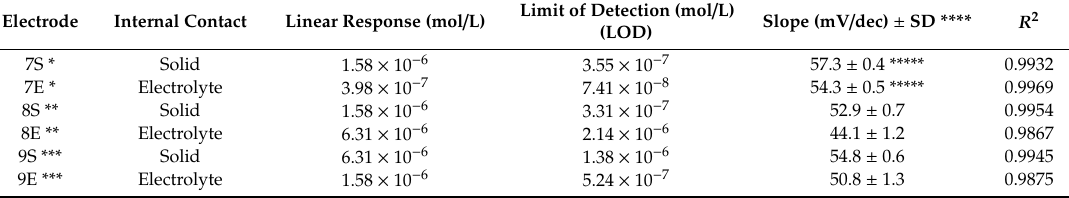
Table 3. The response characteristics of electrodes after washing the Fe x O y NPs out from surface.